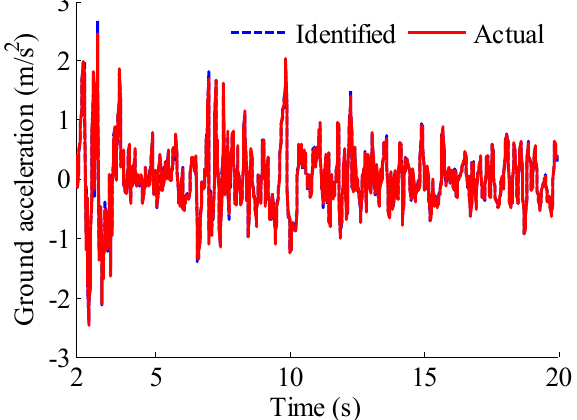
Figure 10. Identified results of the ground acceleration (15 times).